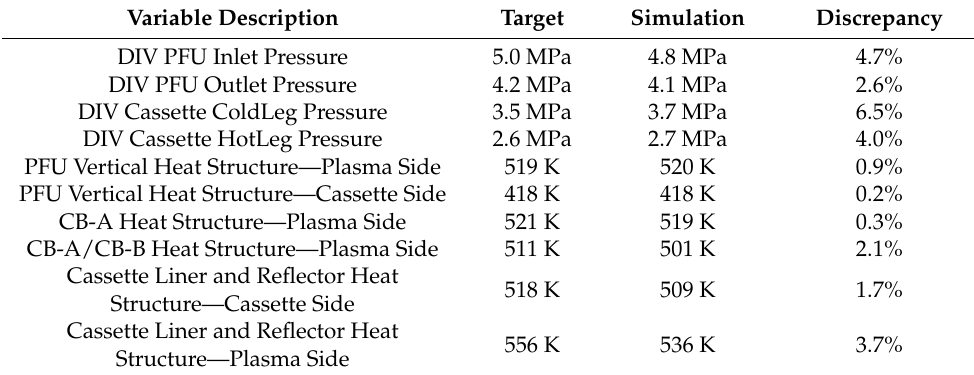
Table 3. Selected parameters considered for steady-state validation.